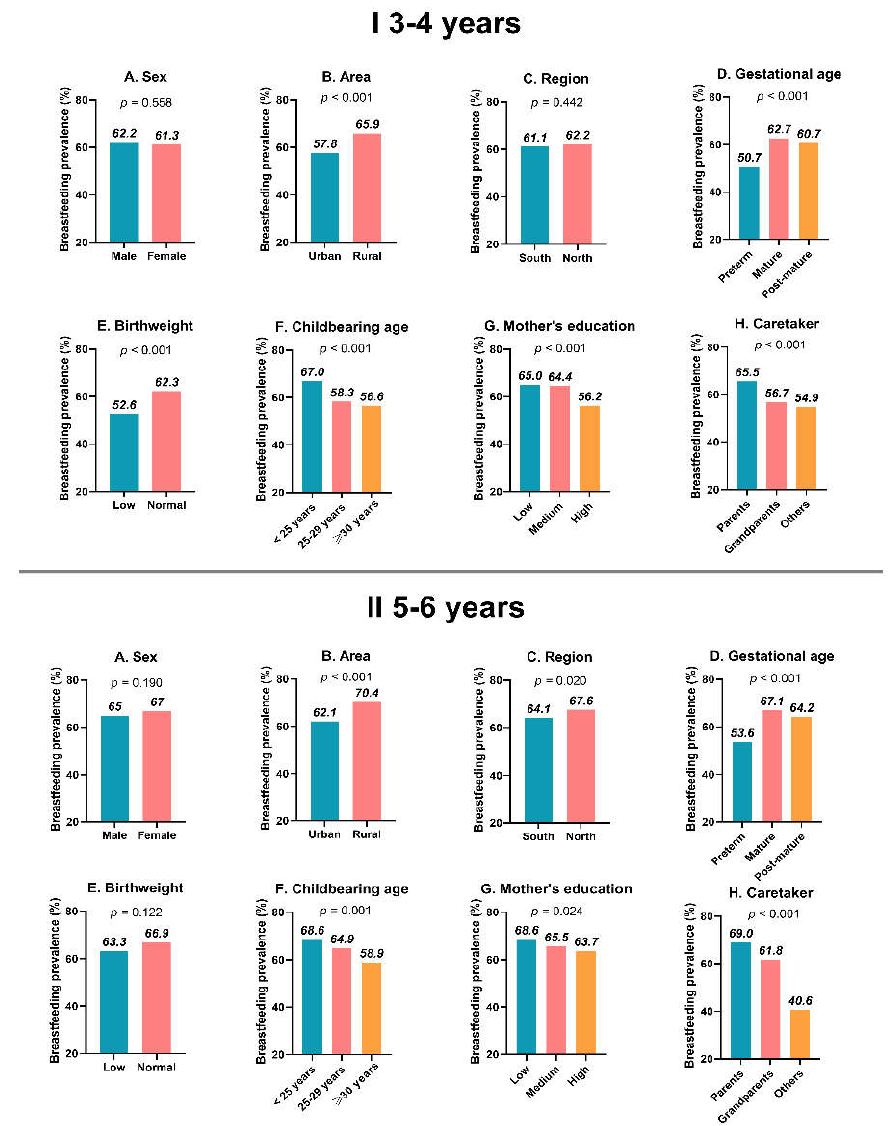
Figure 1. The prevalence of breastfeeding in subgroups. ( I ) 3–4 years; ( II ) 5–6 years .